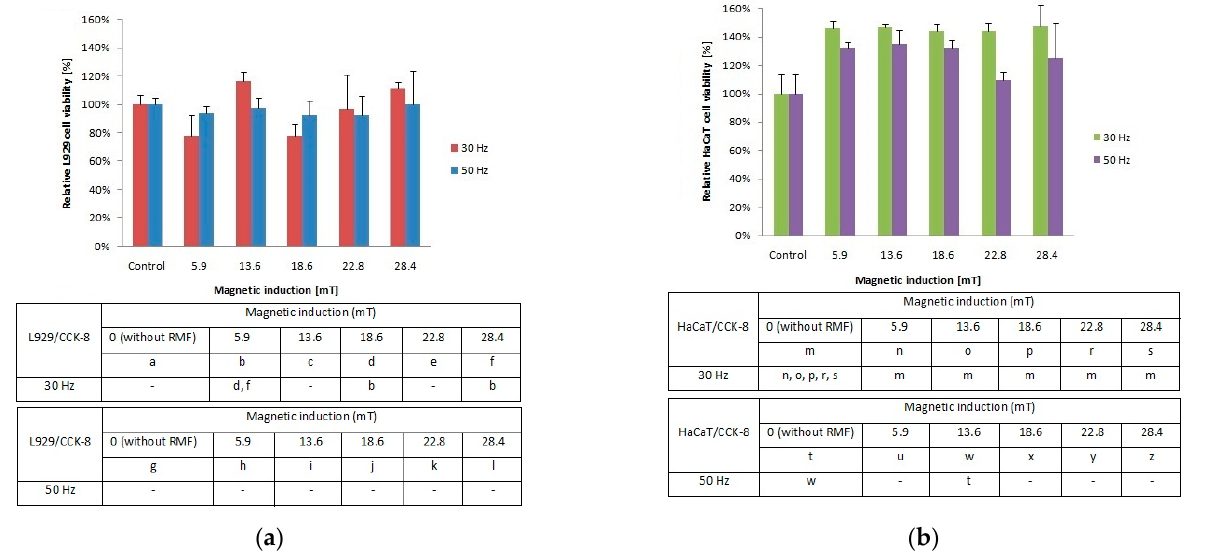
Figure 1. Relative viability after 4-hour exposition to different magnetic induction and frequency of RMF. ( a ) CCK-8 assay results for L929 cell line; ( b ) CCK-8 assay results for HaCaT cell lines (all samples were compared to control; p -values < 0.05 were considered significant and were represented by small letters).